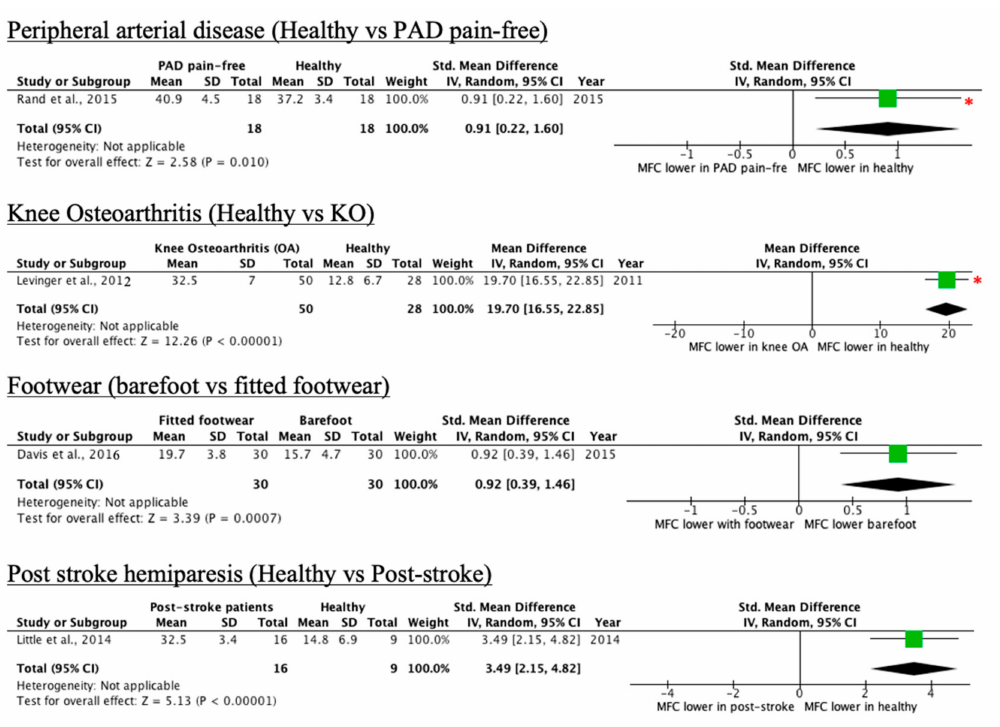
Figure 6. Forest plots of conditions comprising one study with an increase in MFC mean effect relative to control (* = original manuscript reports different finding).